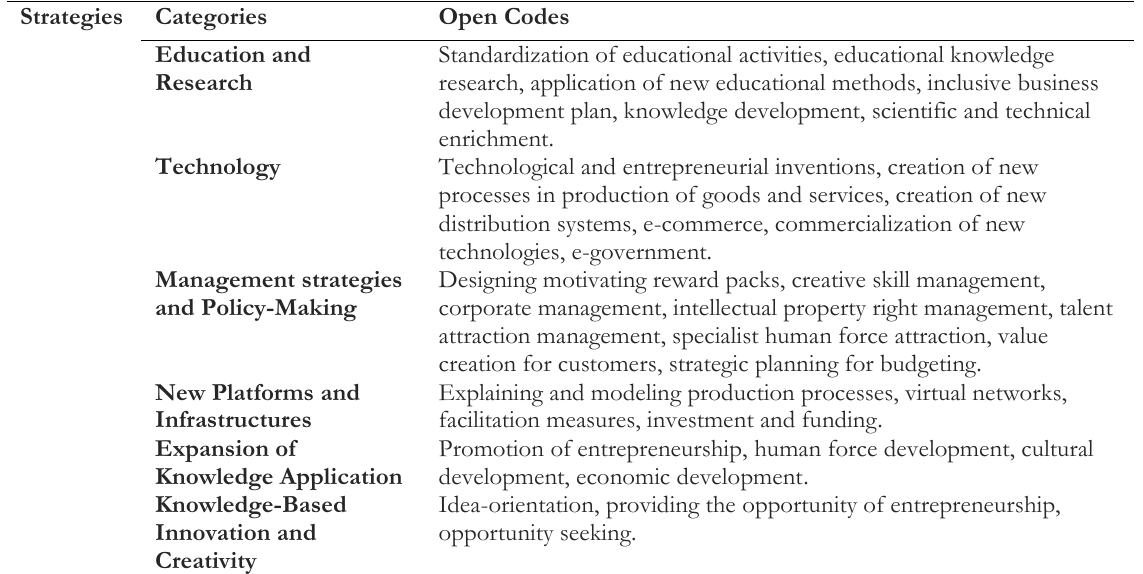
Table 5. Open codes and categories of